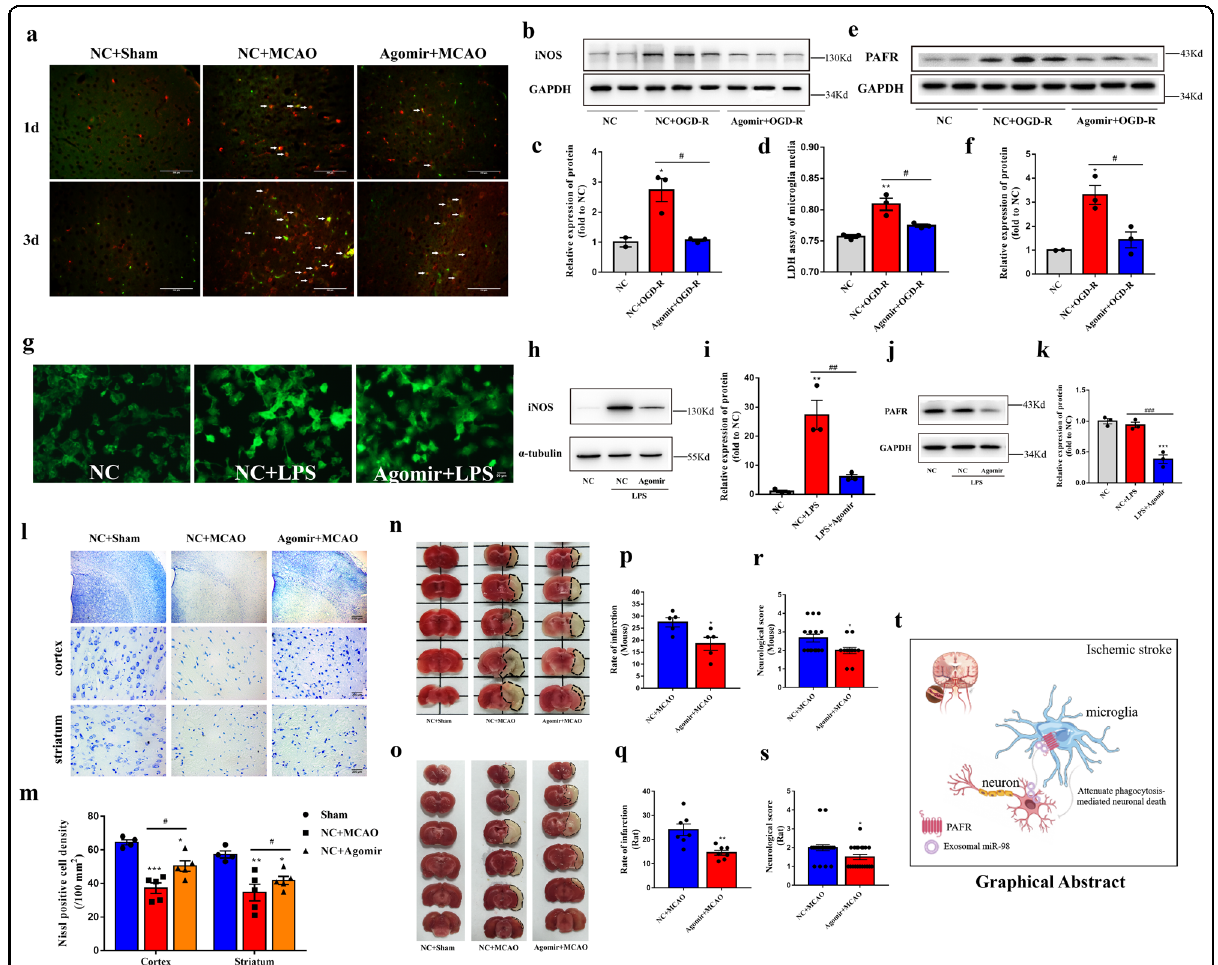
Fig. 6 Overexpression of miR-98 can reduce neuronal damages in ischemic stroke in in vtro and in vivo. a The representative immunostaining of iNOS (green) and IBA1 (red) of mice brain slices 1d and 3d after ischemic stroke. The white arrows are iNOS and IBA1 colocalization. (scale bar = 200 μ m). b – c The protein expression level of iNOS in microglia after OGD-R treatment and miR-98 agomir transfection, and quanti fi cation. d The lactate dehydrogenase (LDH) assay of microglia after OGD-R. e – f The protein expression level of PAFR in microglia after OGD-R treatment and miR-98 agomir transfection, and quanti fi cation. g The representative immunostainings (IBA1) of morphology of microglia. (Scale Bar = 50 μ m). h – k The protein expression level of iNOS, PAFR and quanti fi cation. ( n = 3 independent experiments). l – m The Nissl staining of cells of ipsilateral cortex and striatum and quanti fi cation. ( n = 5 independent experiments). n – s The representative TTC stainings of the mice and rats brain sections and quanti fi cation of TTC stainings ( N = 6 mice for each group, f rats for each group) and neurological function evaluations ( N = 14 mice for each group, 20 rats for each group). t The schematic of neuronal EVs miR-98 transfer hypothesis between neurons and microglia after ischemic stroke. Data are shown as means±S.E.M., * P , # P < 0.05; ** P , ## P < 0.01; *** P < 0.001 vs corresponding